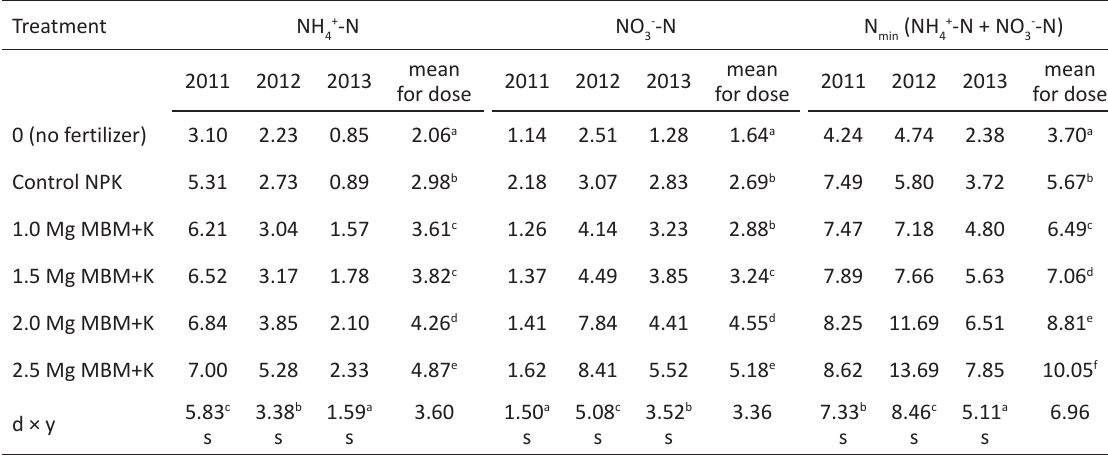
Table 3. The effect of increasing MBM doses on the mineral nitrogen content (mg kg -1 ) of soil Treatment NH 4+ -N